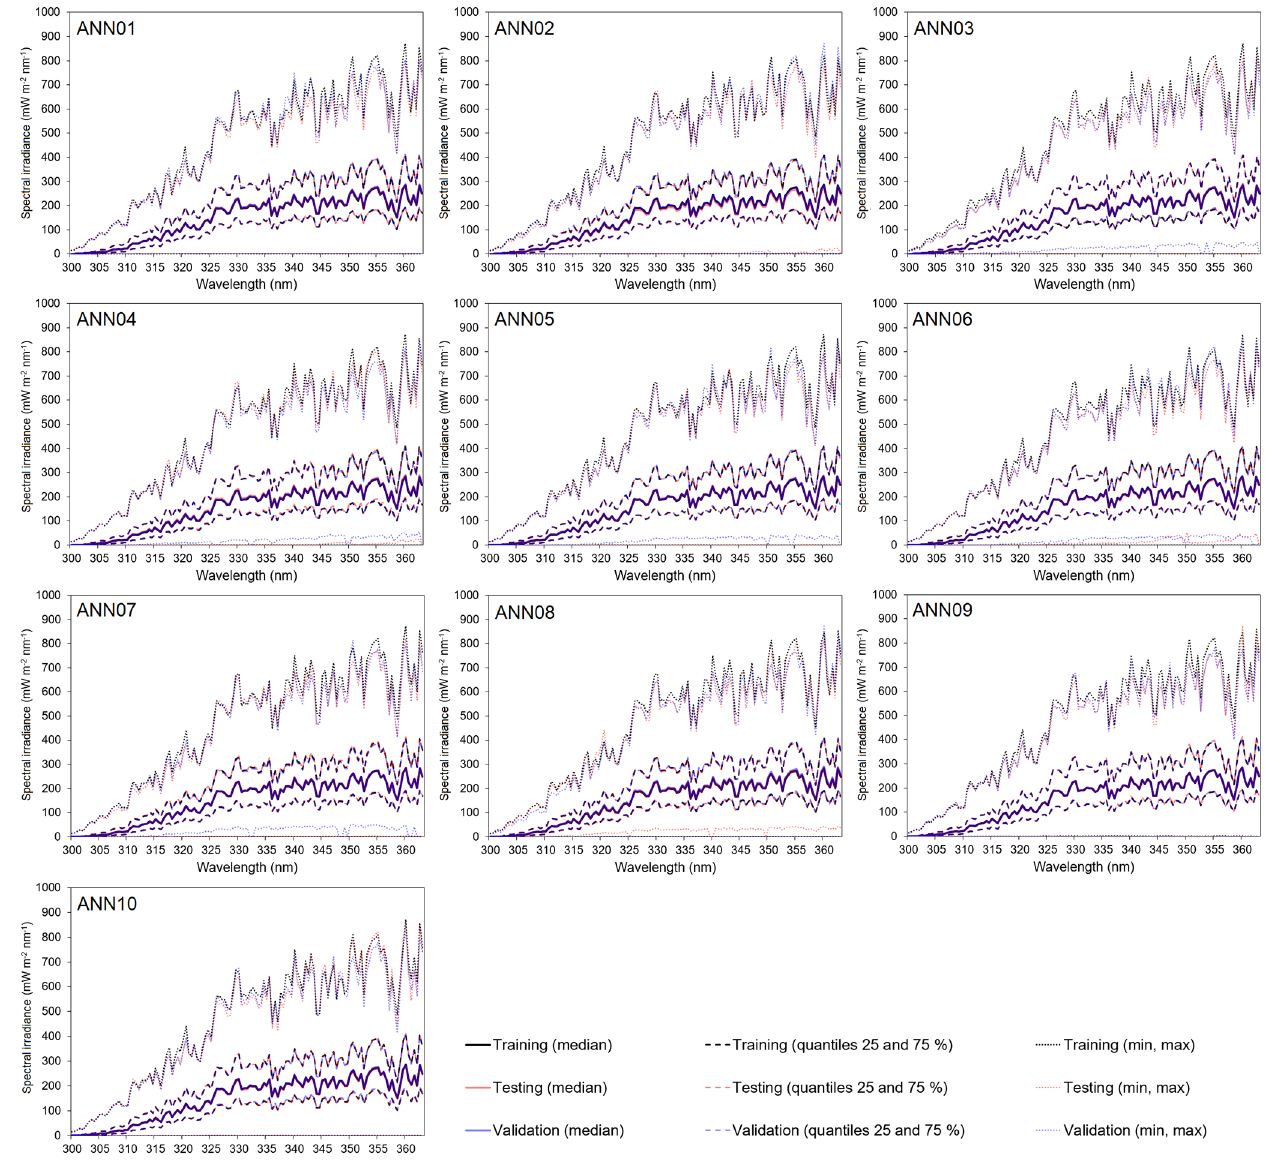
Figure A1. Statistical characteristics of the spectral UV irradiance in training, testing, and validation subsets of the individual ANN models.